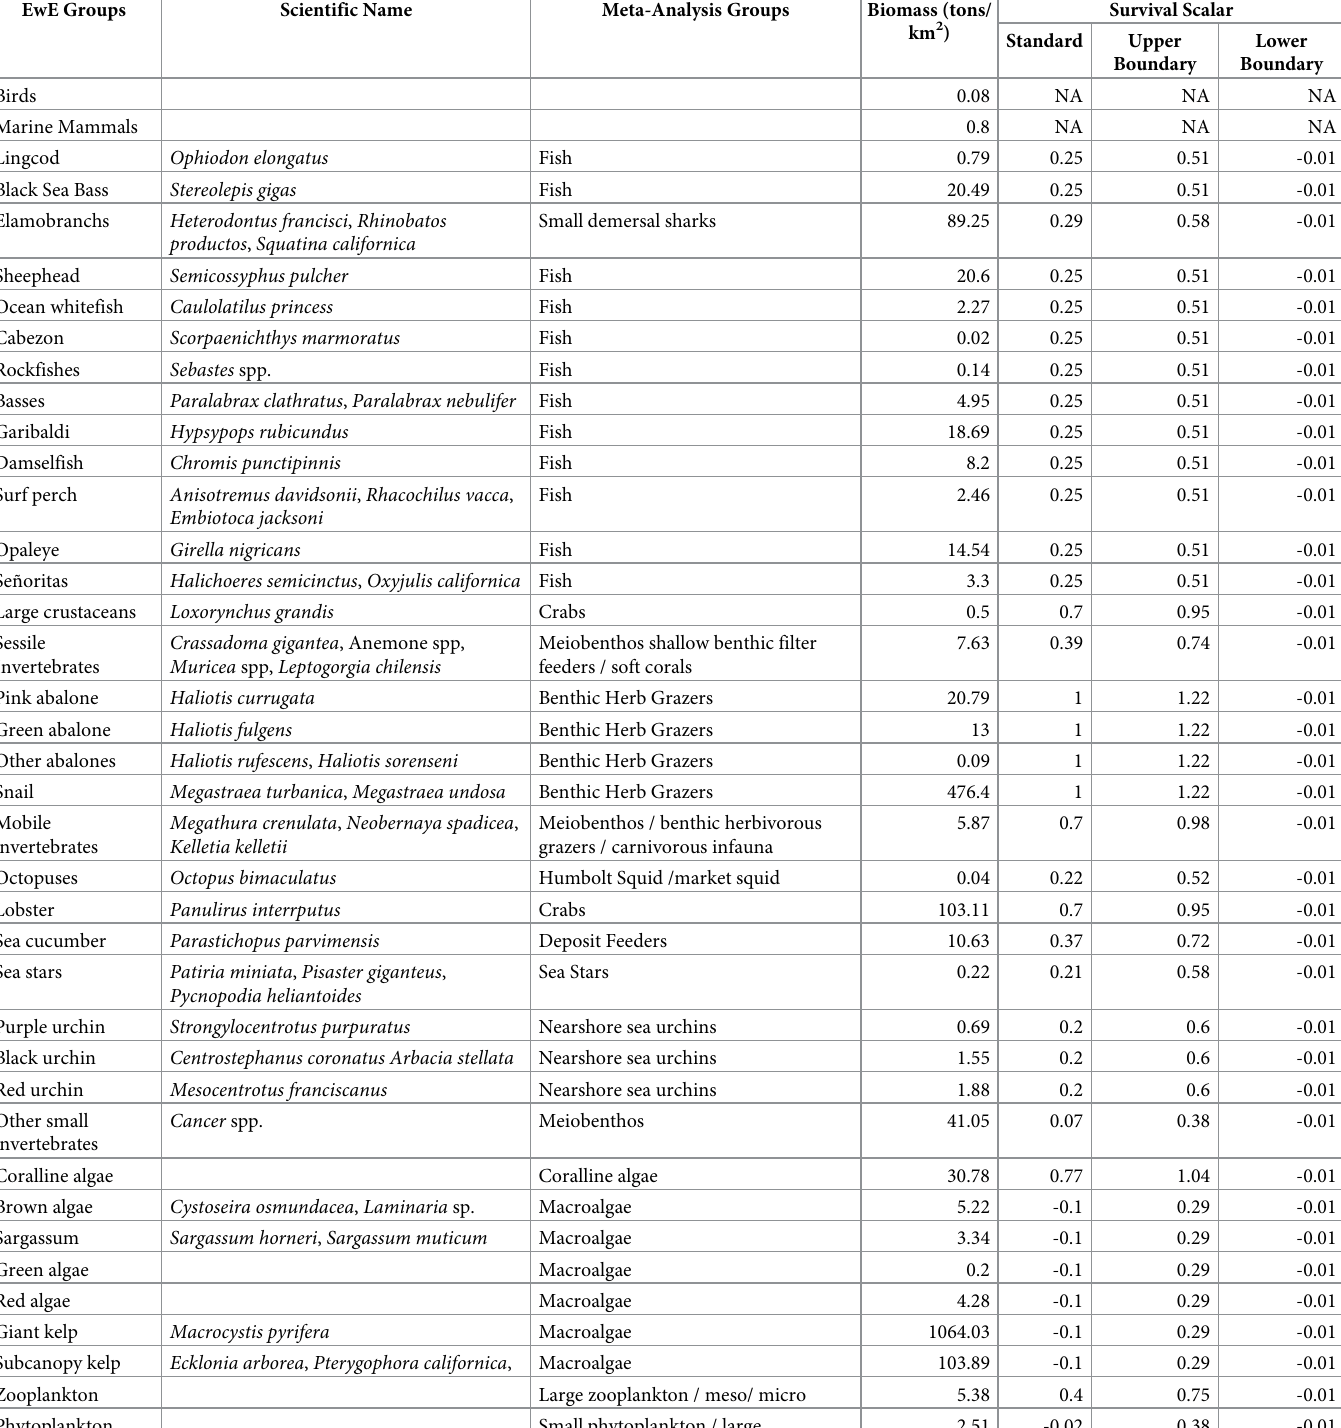
Table 1. Species and functional groups used in the EwE Isla Natividad model along with the OA survival scalars associated with their equivalent functional group taken from the Busch and McElhany (2016) meta-analysis. EwE